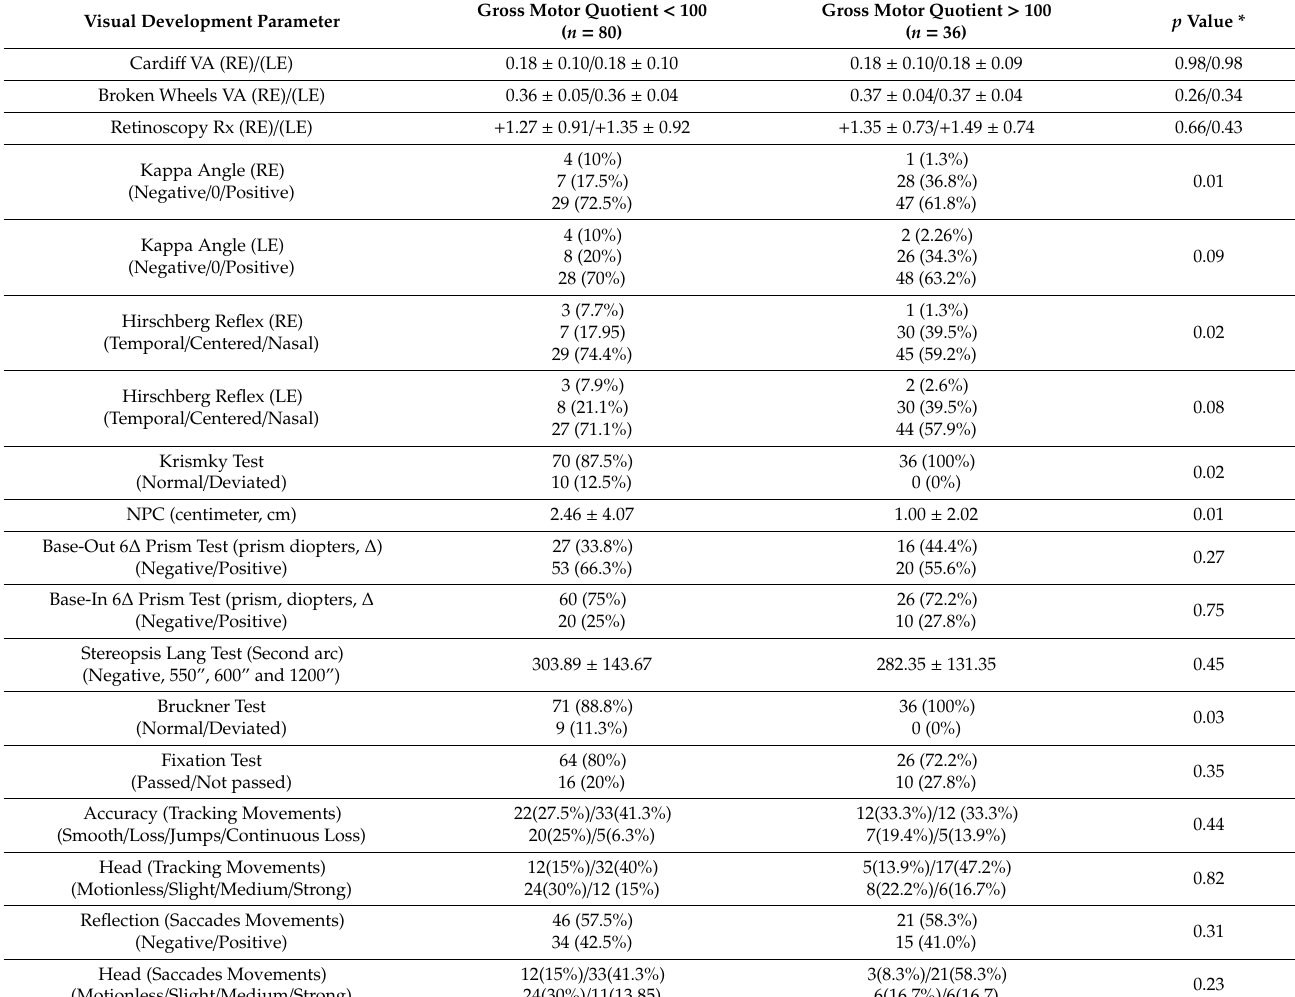
Table 2. Visual development di ff erences between over and under mean quotient for gross motor quotient development. Visual Development